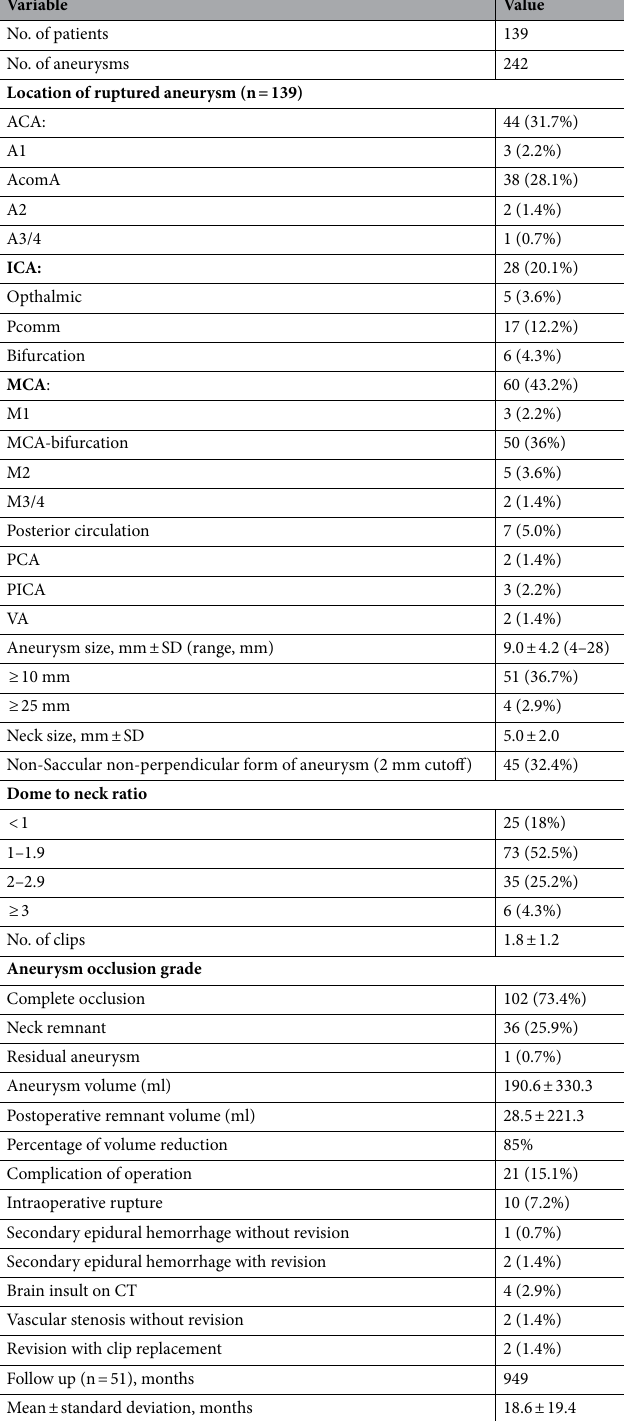
PCA posterior cerebral artery, PICA posterior inferior cerebellar artery, VA vertebral artery, CT computer